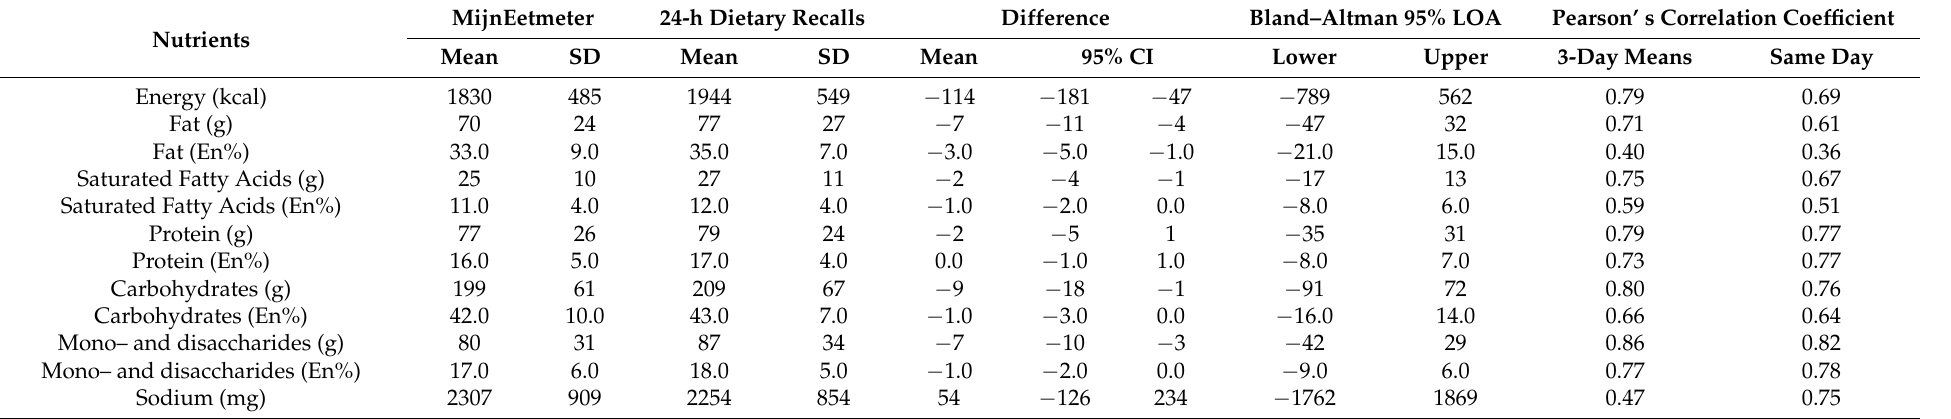
Table 3. Means (SD), differences, and correlation coefficients for energy and nutrient intakes as assessed with ‘MijnEetmeter’ and with 24-h dietary recall in all participants in MijnEetmeter Study ( n = 100)